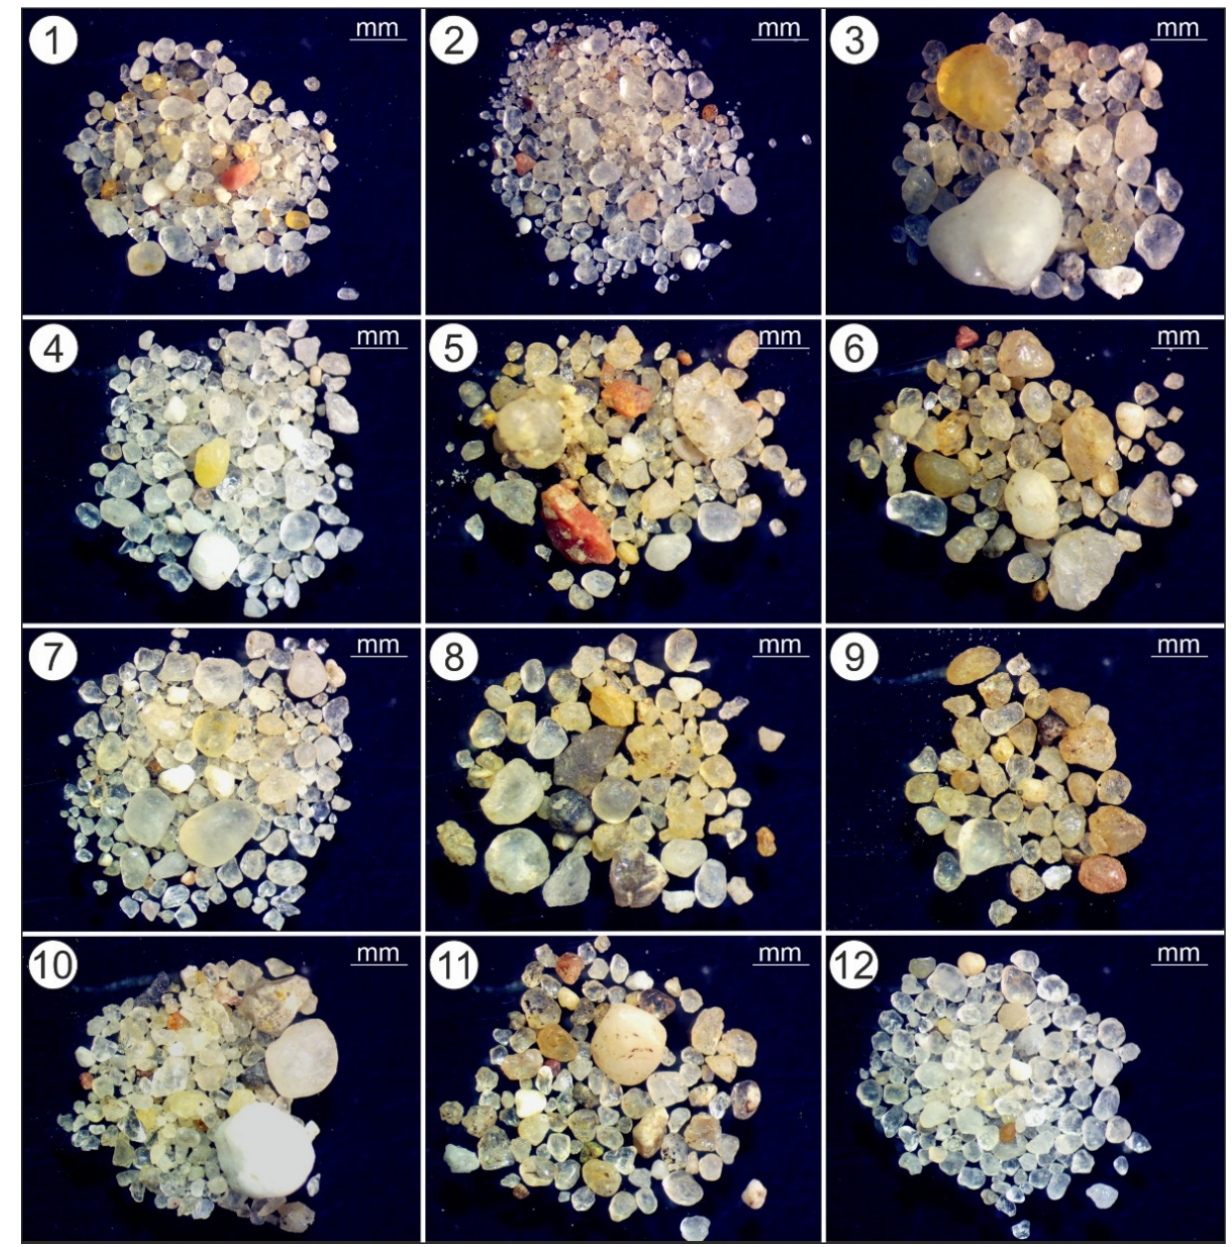
Figure 5. Microscopic images of sand samples taken from beach volleyball courts located in Wrocław (1–11, numbered according to Figure 3) and in the CSC-OPC in Spała (12).